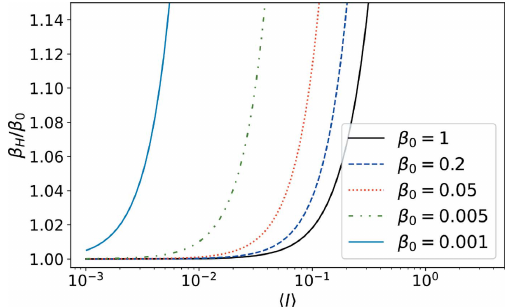
Figure 6 Plot of the estimated speckle contrast (cid:6) H as a function of the mean counts. (cid:6) 0 represents the true visibility. The approximation is worse when the true speckle contrast (cid:6) 0 is weaker.